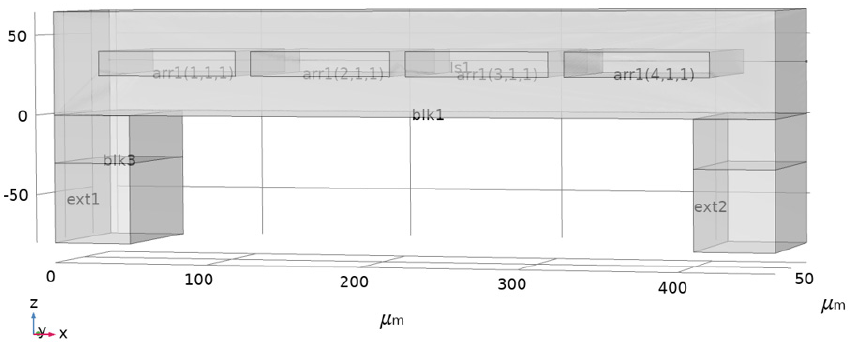
Figure 2. Schematic diagram of the model.